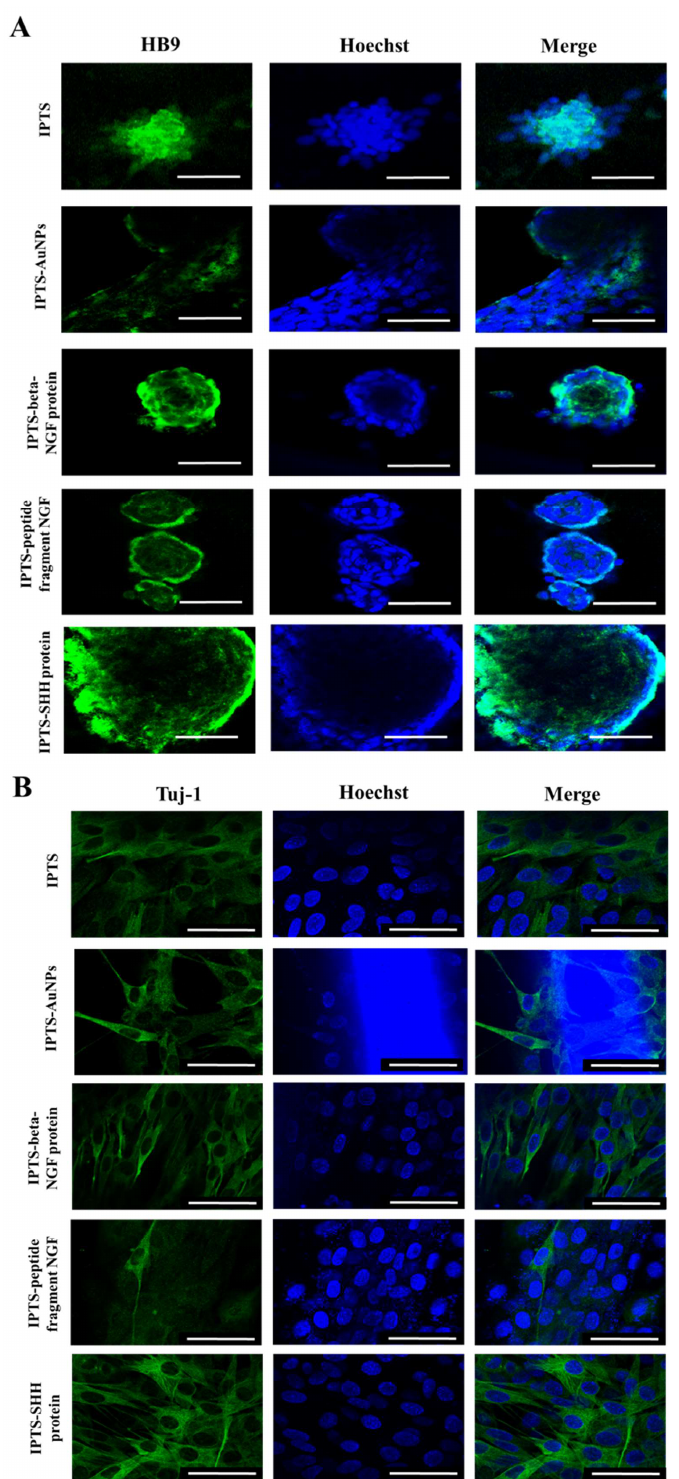
Figure 5. Confocal microscopy images of differentiated F3.Olig2 NSCs cultured on industrial PLA three-dimension scaffold (IPTS) chips coated with gold nanoparticles (Au-NPs), nerve growth factor (NGF) protein, NGF peptide fragments, or sonic hedgehog (SHH) protein. Samples were stained for ( A ) HB9 (green) and ( B ) TUJ-1 (green) using a goat anti-rabbit Alexa Fluor 488 conjugated antibody. Nuclei were stained with Hoechst (blue) (scale bar: 50 µm). The images were obtained using a Carl Zeiss LSM 800 confocal laser scanning microscope and imaged using LSM imaging software (Carl Zeiss).